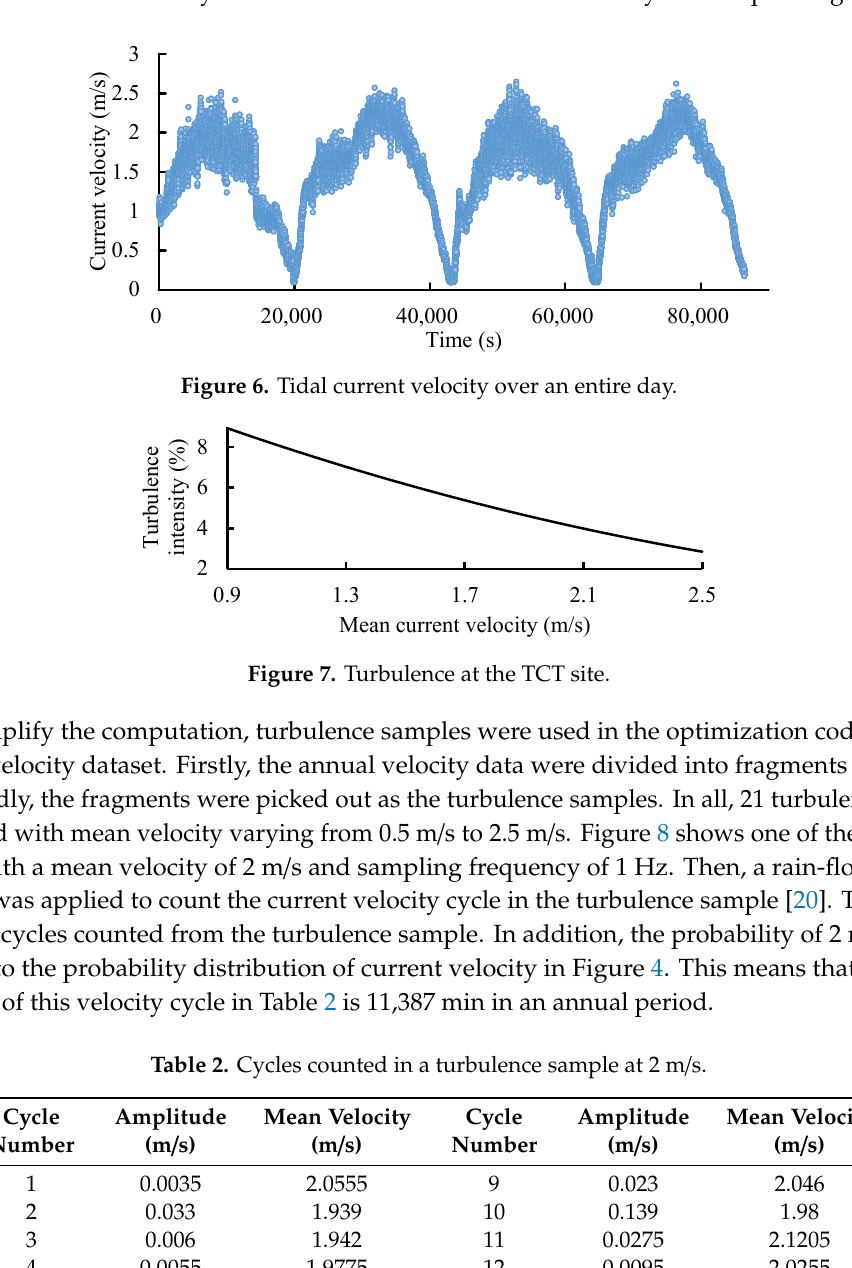
Figure 8. Turbulence sample at 2 m/s. Table 2. Cycles counted in a turbulence sample at 2 m/s.